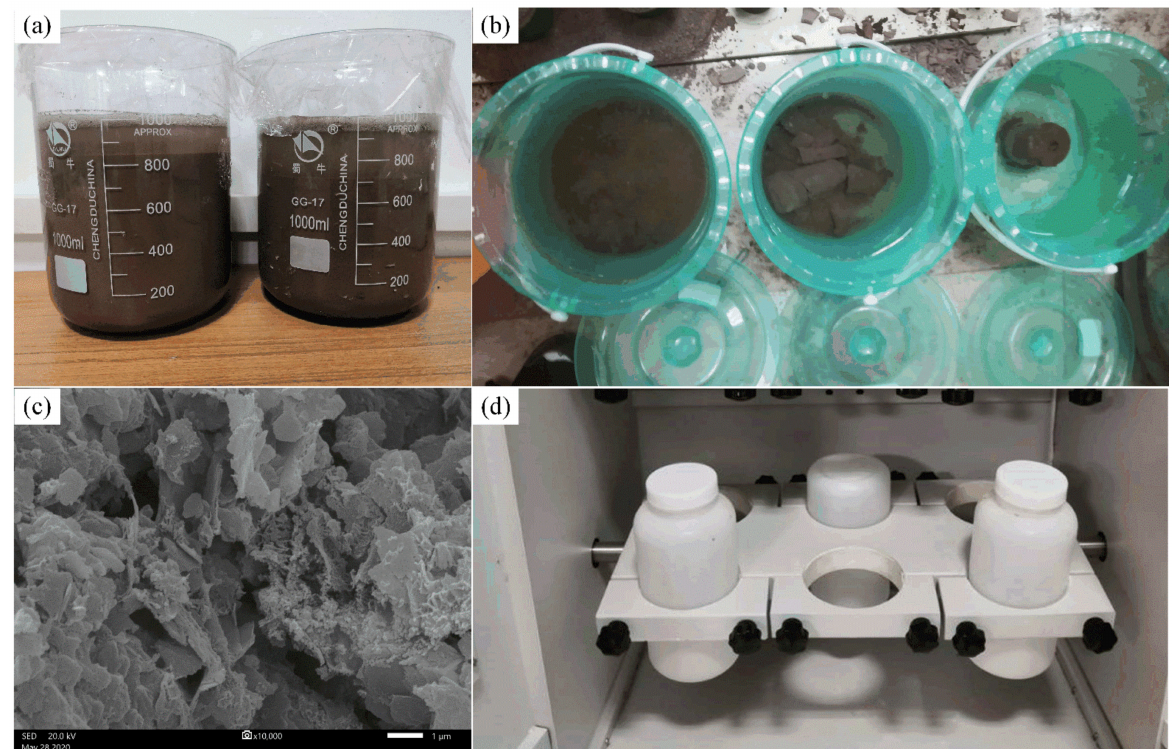
Figure 3. Contamination analysis experiments of RMCB: ( a ) bleeding experiment; ( b ) immersion experiment; ( c ) SEM of RMCB; ( d ) toxic leaching experiment.